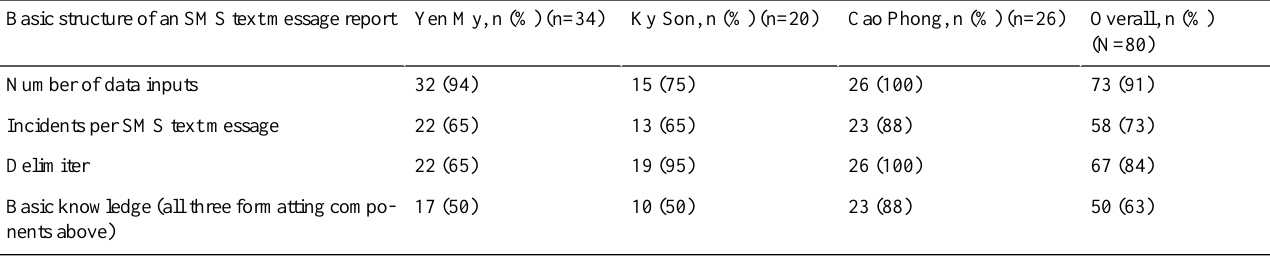
Table 2. Percentage of participants retaining the three formatting structures of an SMS text message report: number of data inputs, incidents per report, and